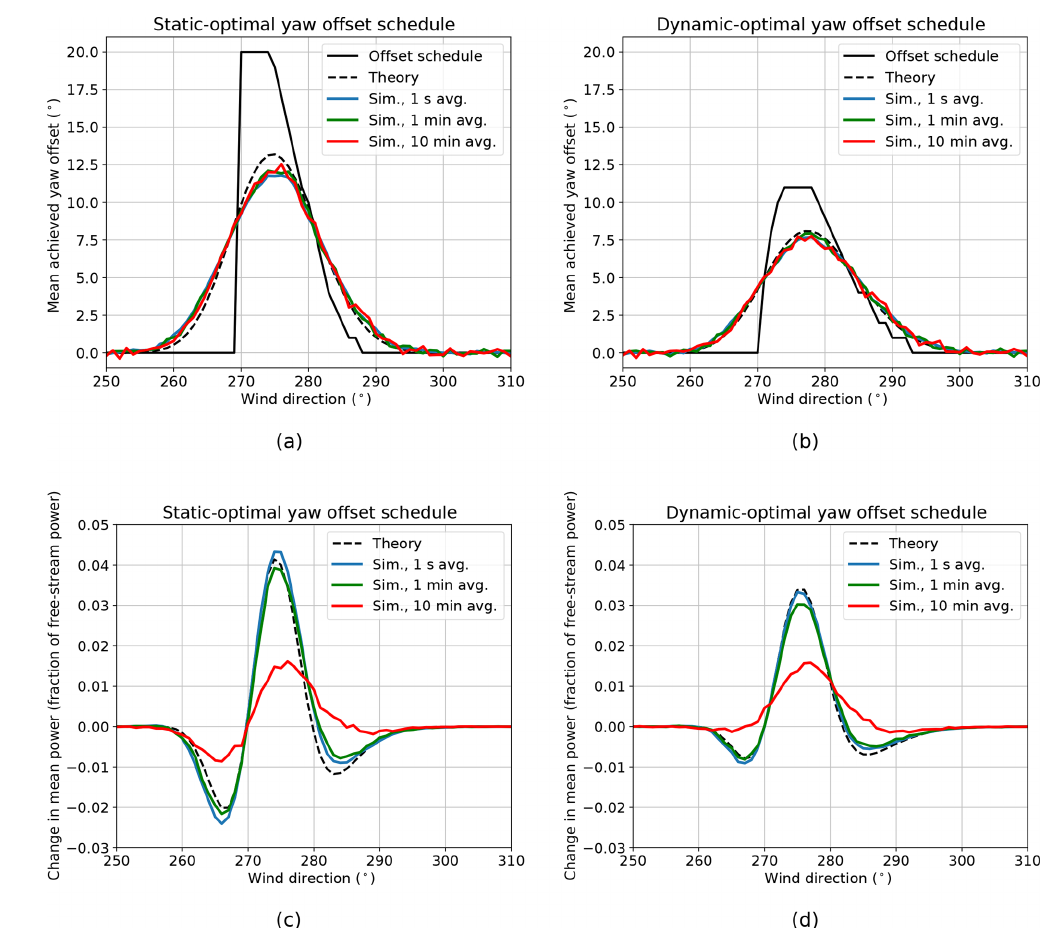
Figure 11. Mean achieved yaw offsets using offset schedules optimized for (a) static and (b) dynamic wind directions as well as change in mean power produced by the turbine pair from wake steering using offset schedules optimized for (c) static and (d) dynamic wind directions as a function of low-frequency wind direction. Theoretical achieved offsets and power gains are shown for dynamic wind directions along with the yaw offset schedules. Achieved yaw offsets and power gains from simulations with dynamic wind directions are provided for 1s, 1min, and 10min averages of low-frequency wind direction, yaw offset, and power. A turbine spacing of 5 D and turbulence intensity of 10% are used in the FLORIS